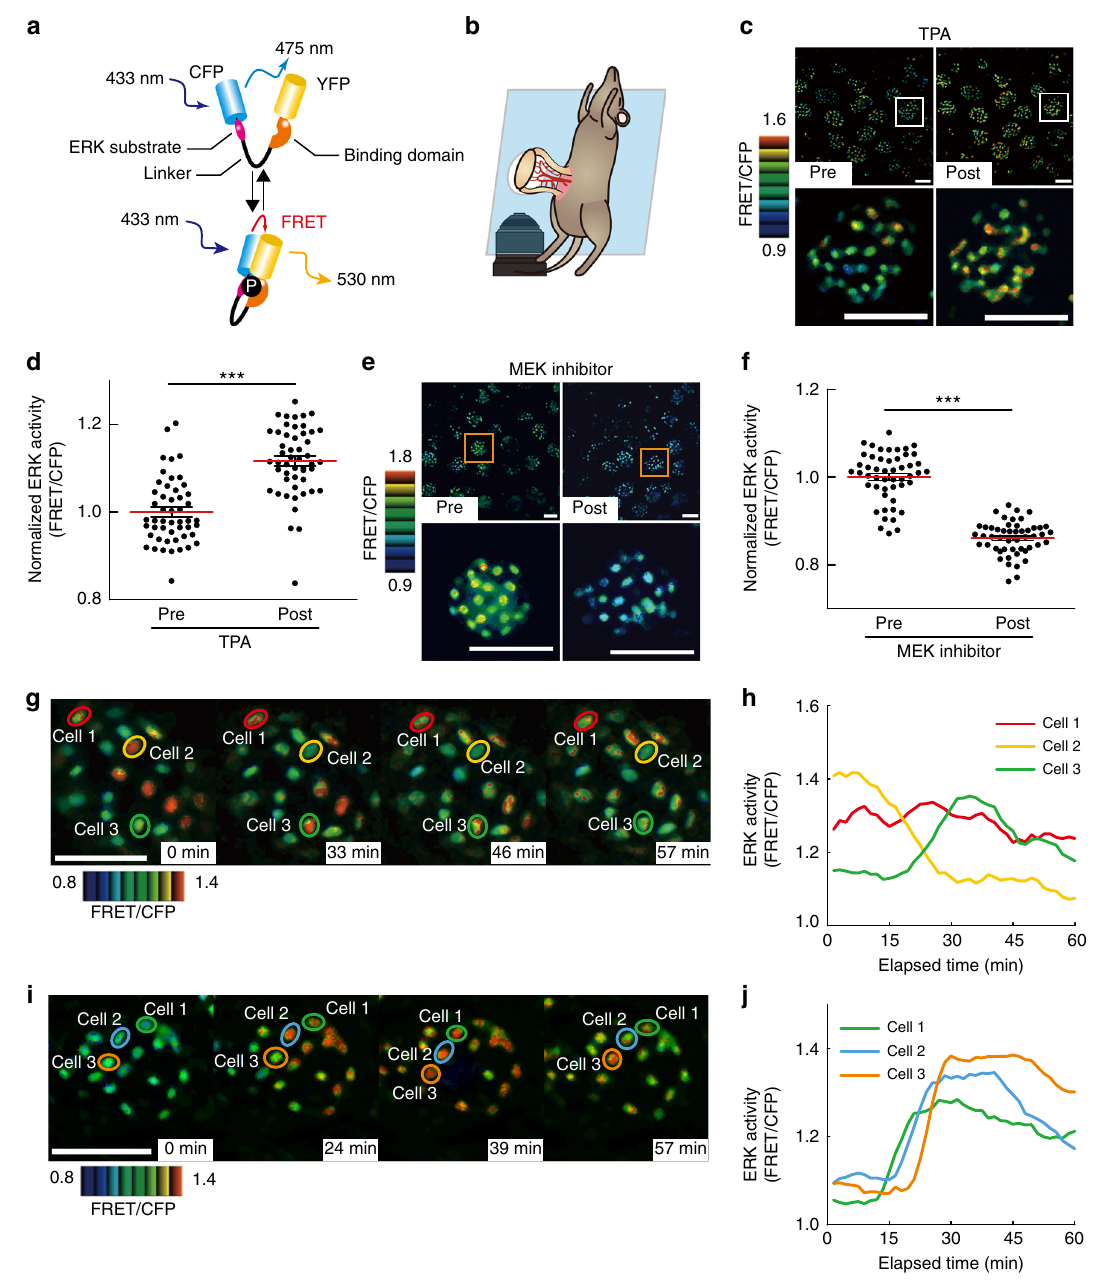
Fig. 1 In vivo imaging of ERK activity dynamics in the mouse small intestine. a Schematic representation of the structure of the FRET biosensor for ERK activity, EKAREV-NLS, and its mechanism of action. Upon activation, ERK phosphorylates the substrate sequence in the biosensor. The WW domain speci fi cally binds to the phosphorylated substrate, which brings CFP and YFP into close proximity. In this “ closed ” conformation state, excitation energy absorbed by CFP is transferred to YFP without radiation, thereby enabling YFP to emit fl uorescence. The biosensor returns from the “ closed ” to the original “ open ” conformation by phosphatase-dependent dephosphorylation of the substrate sequence. b Experimental setting of in vivo imaging of the small intestine. The mouse small intestine was exteriorized, fi xed on the microscope stage, and observed with an inverted two-photon excitation microscope under inhalation anaesthesia. c The representative FRET/CFP images of the small intestine of EKAREV-NLS mice before and after administration of 0.1 mg kg − 1 body weight of TPA. d Bee swarm plots showing the ERK activity (FRET/CFP ratio) in each cell before and after the TPA ( n = 50 cells pooled from three crypts). e The representative FRET/CFP images of the small intestine of EKAREV-NLS mice before and after administration of 5 mg kg − 1 body weight of a MEK inhibitor (PD0325902). f Bee swarm plots showing the FRET/CFP ratios in each cell before and after MEK inhibitor treatment ( n = 50 cells pooled from three crypts). g – j In vivo time-lapse imaging of intestinal crypts of EKAREV-NLS mice. The representative images ( g , i ) and quanti fi ed data from three selected cells (cells 1 – 3) ( h , j ) are shown. Note that the ERK activity pulses are spontaneously generated ( g , h ), or propagated from adjacent cells ( i , j ). The original time course data of ERK activity used for h and j before smoothing by the moving average are shown in Supplementary Fig. 1b, c. Scale bars, 50 µ m. Red lines represent mean. Error bars represent s.e.m. Mann – Whitney U -tests were used for comparison ( d , f ). * P < 0.05, ** P < 0.001, *** P <